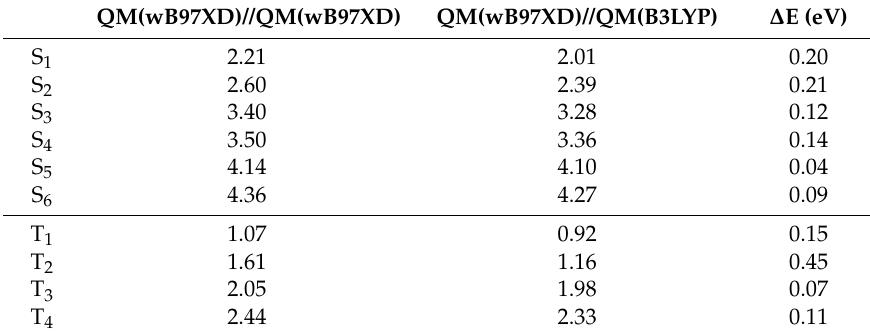
Table 1. Excitation energies in eV of the lower lying singlet and triplet states of mTHPC computed with the static approach at the QM(wB97XD)//QM(wB97XD) and the QM(wB97XD)//QM(B3LYP) level of theory. The energy differences between the two methods is also reported in